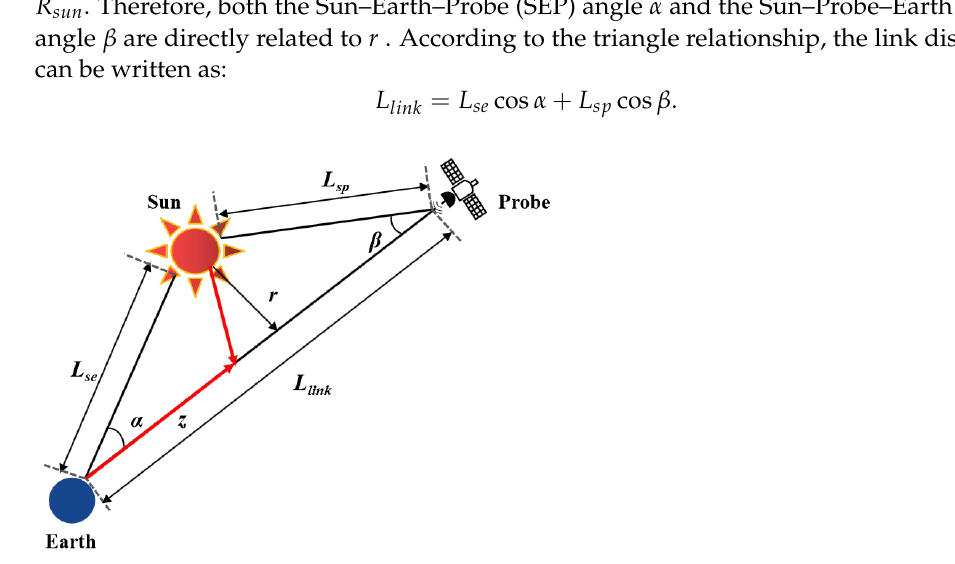
Figure 1. Geometric diagram for deep space communication during superior